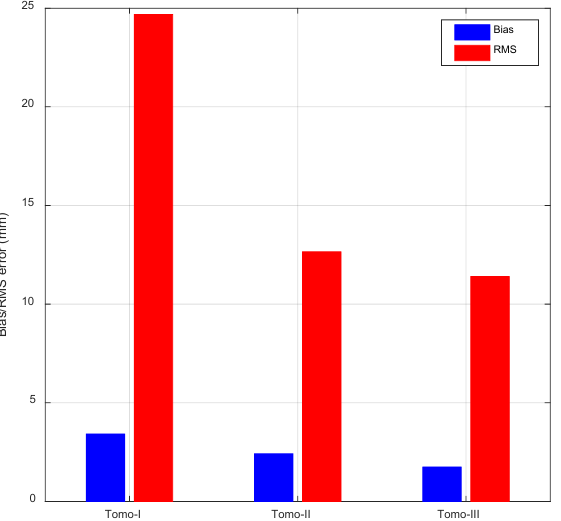
Figure 3. Biases and root mean square (RMS) errors of the tomographic slant wet delays (SWDs) solved using schemes Tomo-I, Tomo-II, and Tomo-III.